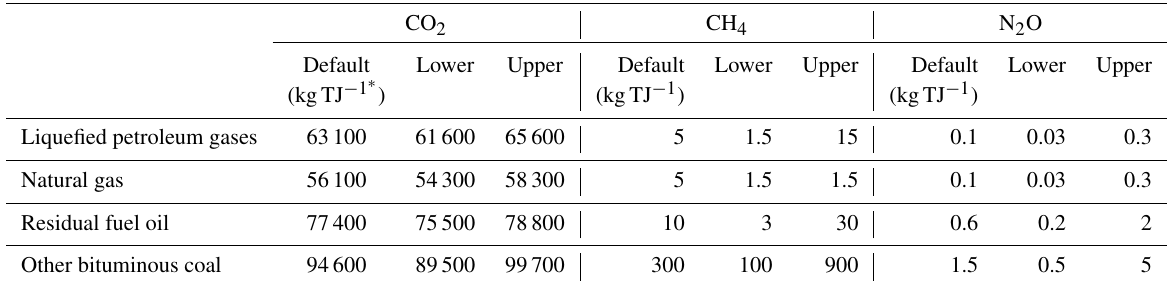
Table 2. Fuel-specific emission factors for stationary combustion in the residential and agriculture/forestry/fishing/fishing farms categories applied (IPCC,